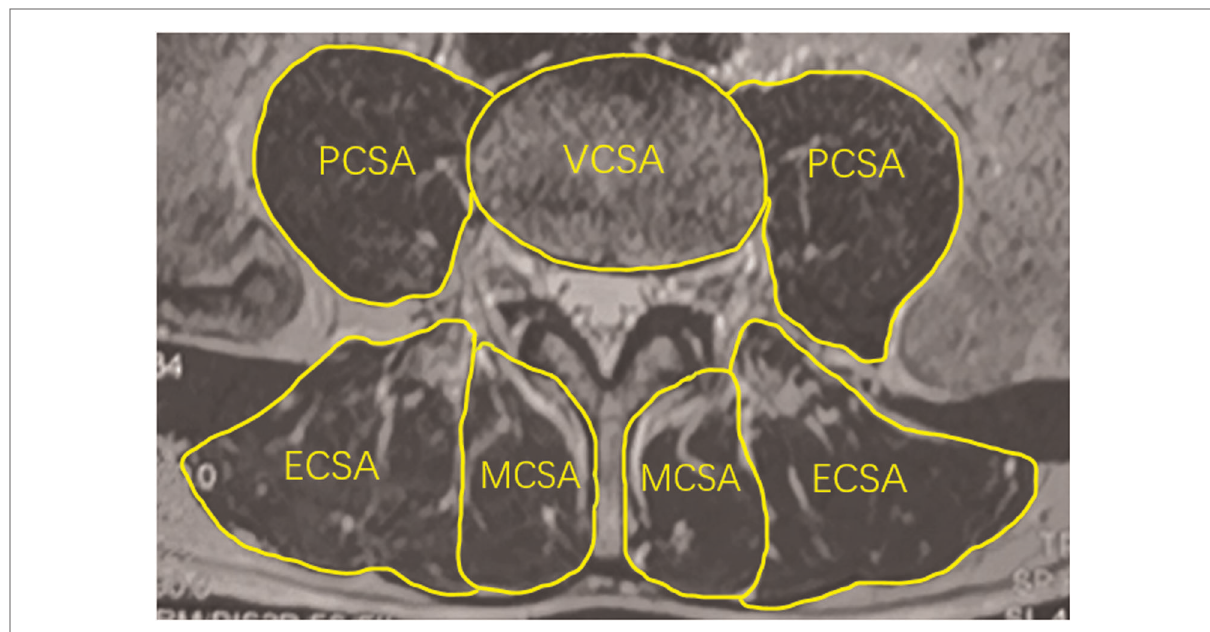
FIGURE 4 Measurement method of relative cross-sectional area of paraspinal muscles. MCSA, the CSA of multi fi dus muscle; ECSA, the CSA of erector spinae muscle; PCSA, the CSA of psoas major muscle; VCSA, the CSA of the L4 vertebral